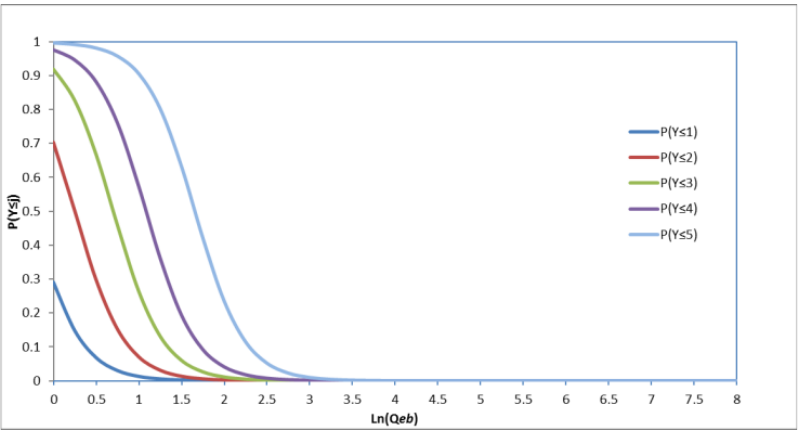
Figure 5. Example cumulative logit distribution of LOS.